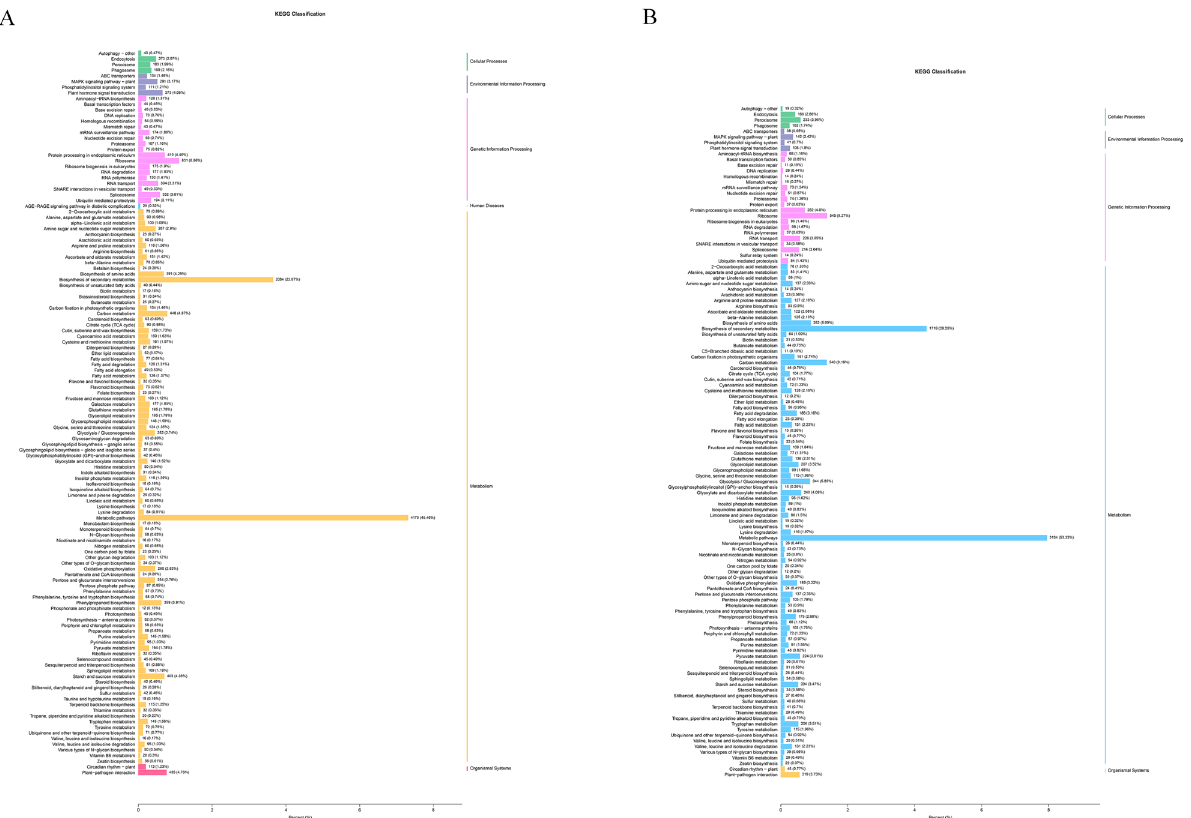
Figure 4. The classification column of KEGG from the DEGs between large and small flower taxa. The x-axis represents the proportion of genes annotated to the pathway in the total of annotated genes. The y-axis represents the name of KEGG pathway. The labels represent the classification of KEGG pathway. ( A) In flowers. ( B) In